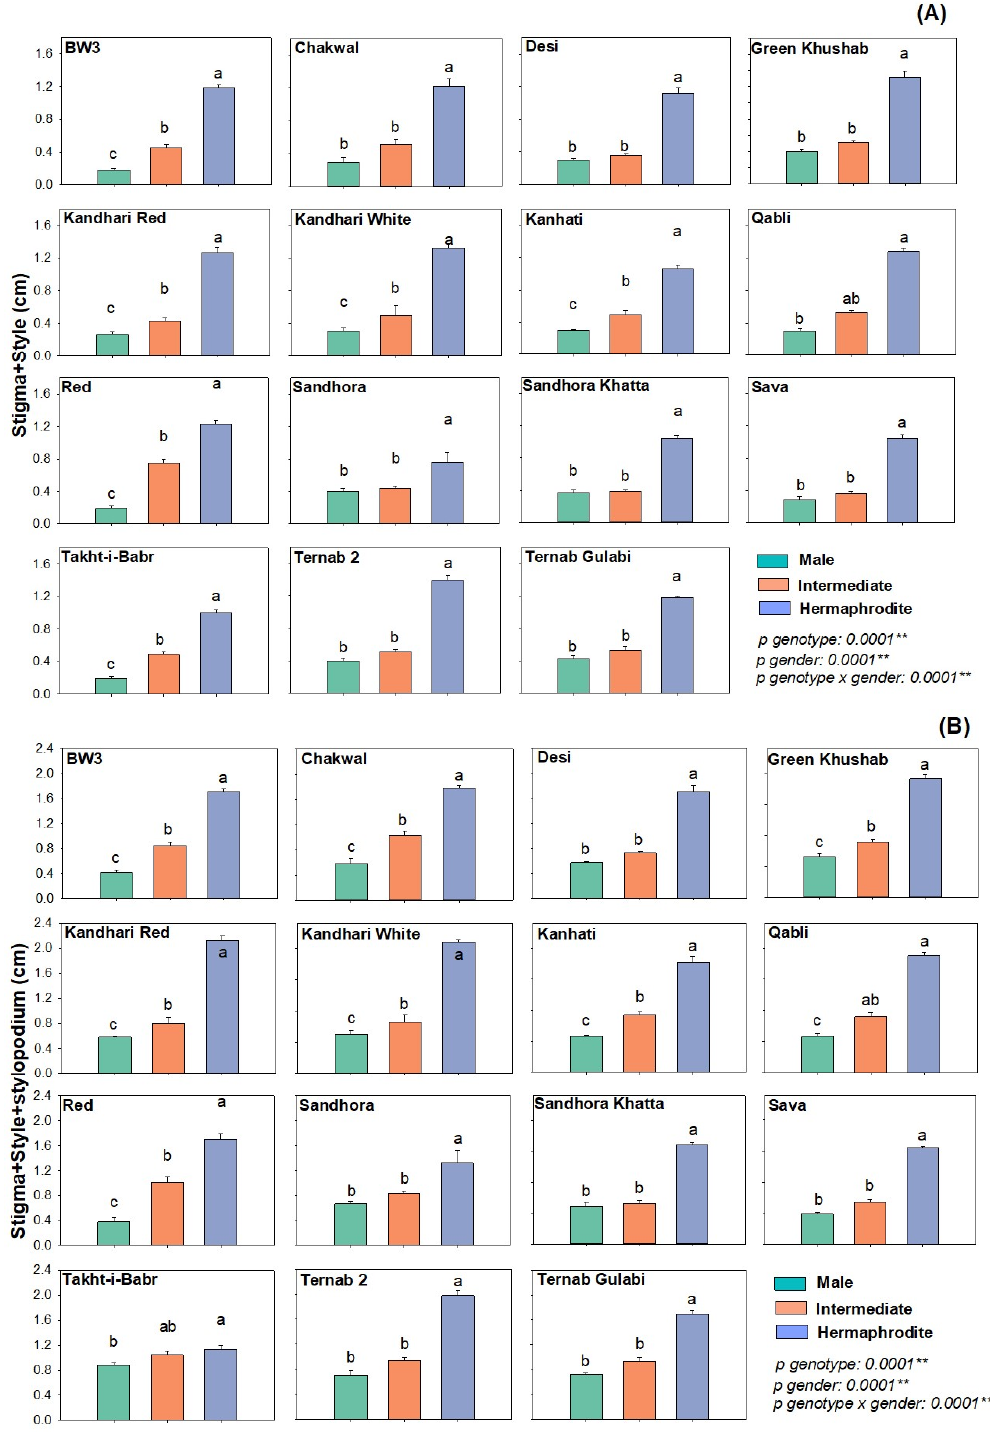
Figure 3. Heterostyly parameters of pomegranate genotypes in different flower